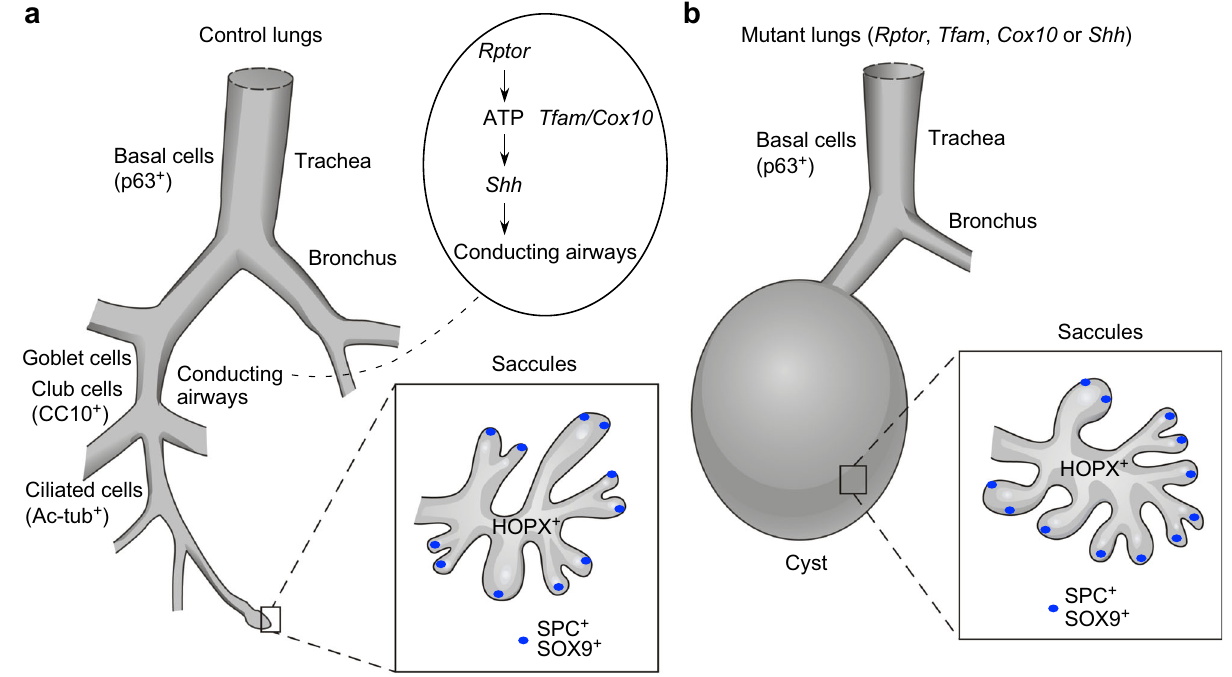
Fig.10|Amodeloflungbranchingandsacculeformation.a Schematicdiagram of lung branching and saccule formation in control lungs. The conducting airways extend from the trachea and main stem bronchi. A signaling cascade that involves mTORC1 ( Rptor ) signaling, mitochondrial capacity ( Tfam and Cox10 ) and Hedge- hog (Hh) signaling controls lung branching to form the conducting airways. Sac- culesaresubsequentlygeneratedattheendoftheconductingairways.Production of the conducting airways and saccules is also closely associated with proper cell